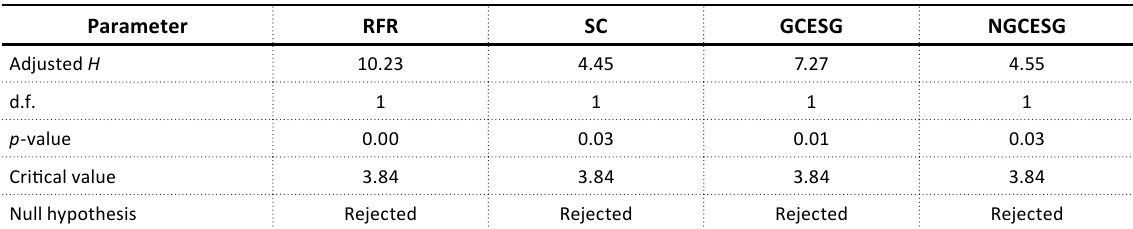
Table C3. Mann-Whitney tests of the differences between developed countries and developing and emerging countries Parameter RFR SC GCESG NGCESG Adjusted H